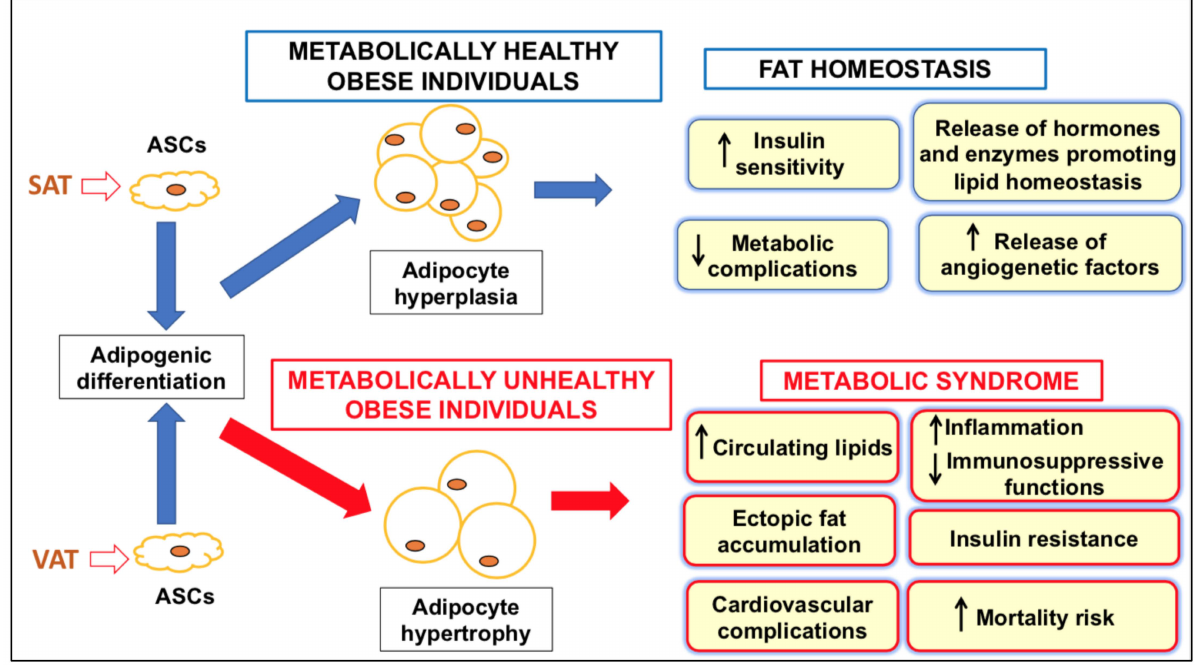
Figure 1. Schematic representation of the events occurring in metabolically healthy or unhealthy obese subjects. SAT-ASCs have the main function of regulating fat homeostasis in the AT, while VAT-ASC hypertrophy contributes to the onset of metabolic syndrome. Abbreviations: ASCs, adipose stromal/stem cells; SAT, subcutaneous adipose tissue; VAT, visceral adipose